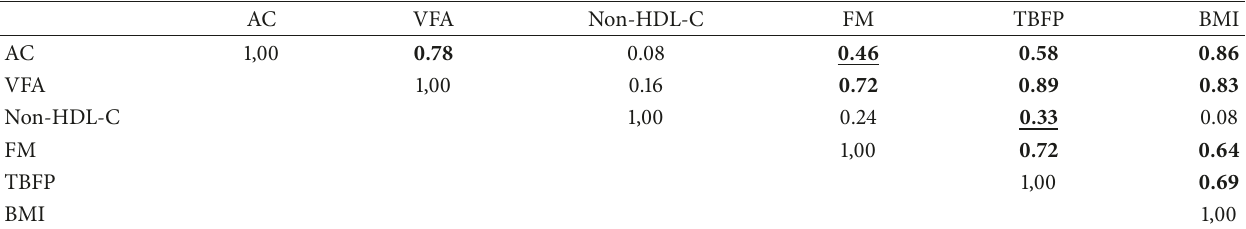
Table 8: Pearson simple correlation coefficients among abdominal circumference (AC), visceral fat area (VFA), non-HDL cholesterol